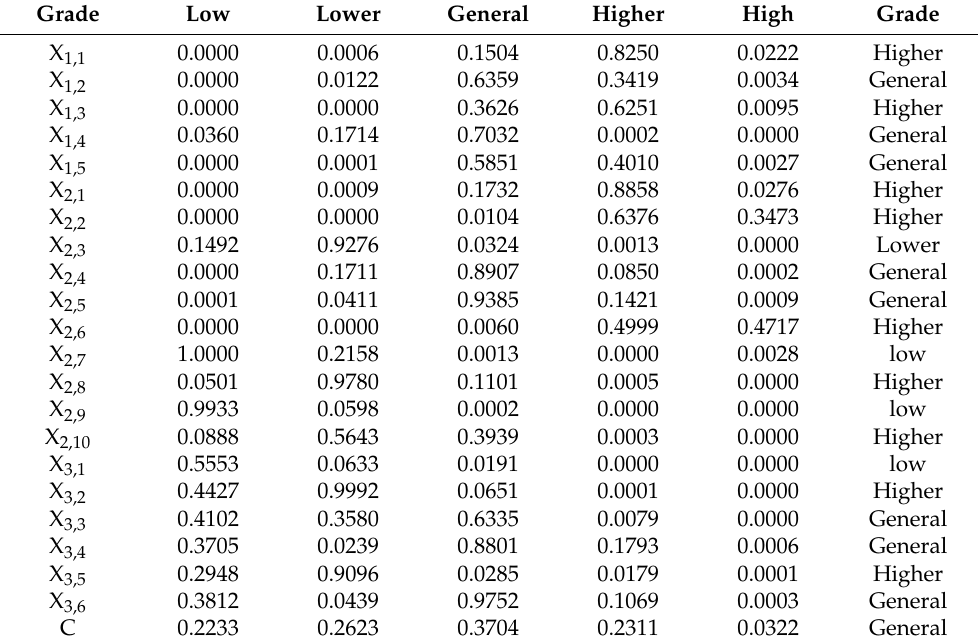
Table 8. Indicator affiliation with Beijing 2013 as an